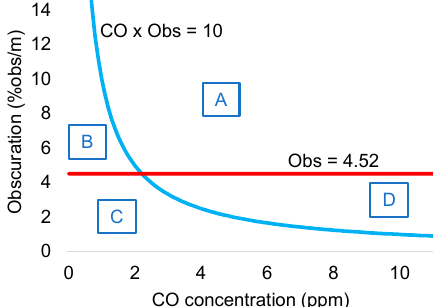
Figure 9. The coupling of CO measurement to light obscuration detector allows the definition of more specific fire/non-fire regions. Light obscuration detectors traditionally set fire alarm when the signal reaches a certain threshold (4.52% obs/m in this example, red line). The function Obs = 10/[CO] (blue line) defines a new boundary for fire/non-fire regions. Region A: Multi-sensor and smoke detectors output fire alarm. Region B: Only smoke detector outputs fire alarm. It is assumed that high obscuration signal and low CO concentration corresponds to nuisance scenario (water steam, dust, etc.). Region D: Only multi-sensor system outputs fire alarm. High CO concentration levels may come from incomplete combustion processes. Region C: No alarm region. Adapted from [67]. The multi-sensor system was compared to traditional smoke detectors. Despite the simplicity of the proposed rule, the multi-sensor system detected 42 out of 53 fire tests, while ionization and photoelectric detectors detected 25 and 29 of the tested fires, respectively. Briefly, the multi-sensor system detects the union of the set of fires that are detected by the ionization and the photoelectric detectors, except for some smoldering wood (at lower temperature) and PVC cable, which can be detected by photoelectric detector and did not trigger alarm for the ionization smoke + CO detector.